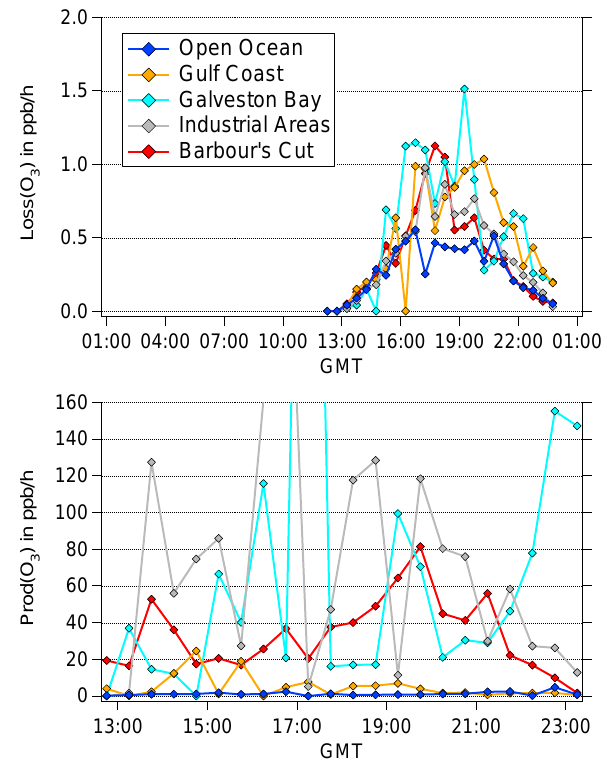
Fig. 8. Median profiles of Loss( O 3 ) and Prod( O 3 ) at different locations during the R/V Brown cruise.